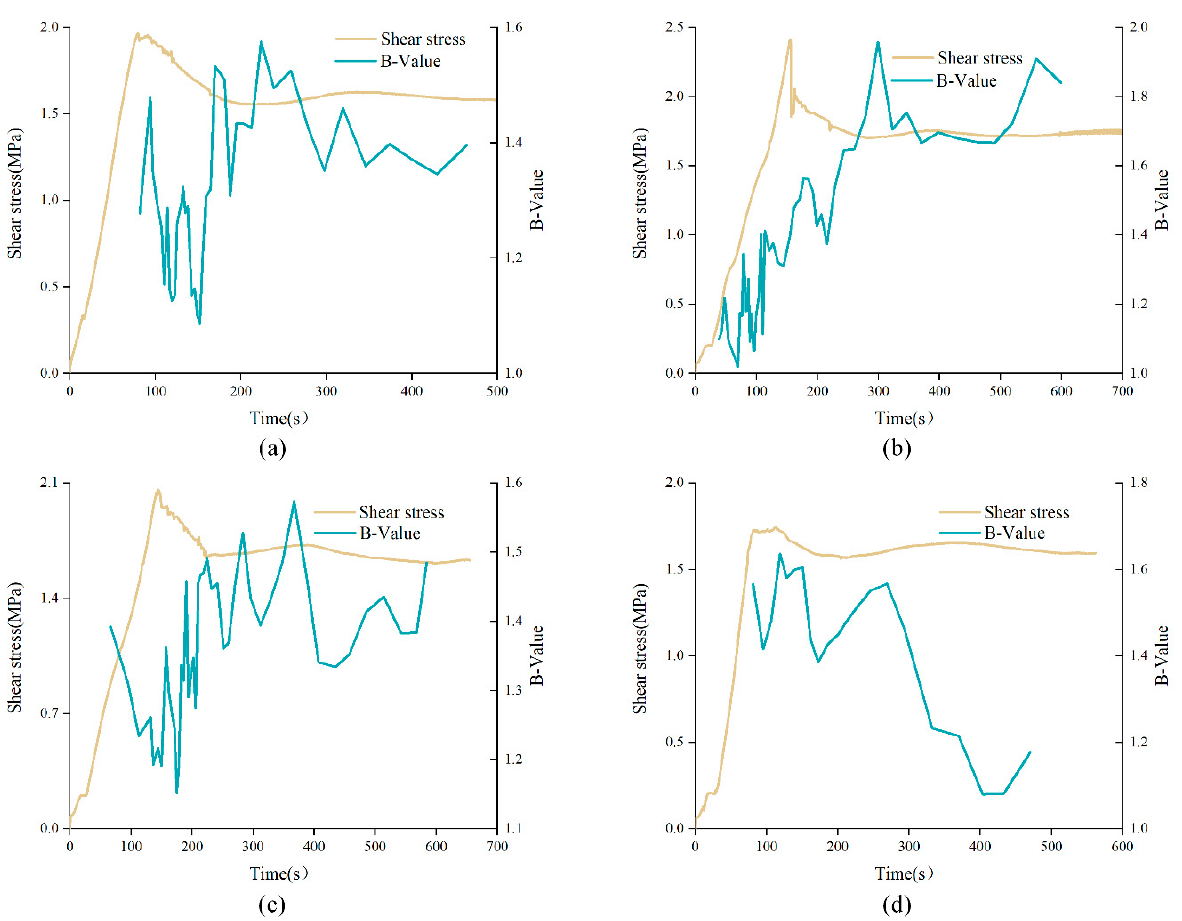
Figure 14. b -value curves of anchored structural planes with different anchorage angles under shearing: ( a ) DS-02-30-2, ( b ) DS-02-45-2, ( c ) DS-02-60-2, and ( d ) DS-02-90-2 (specimen ID: DS-ab- α - σ , where DS represents direct shear experiment, ab represents the range of JRC, α means the anchorage angle, and σ means the normal stress).